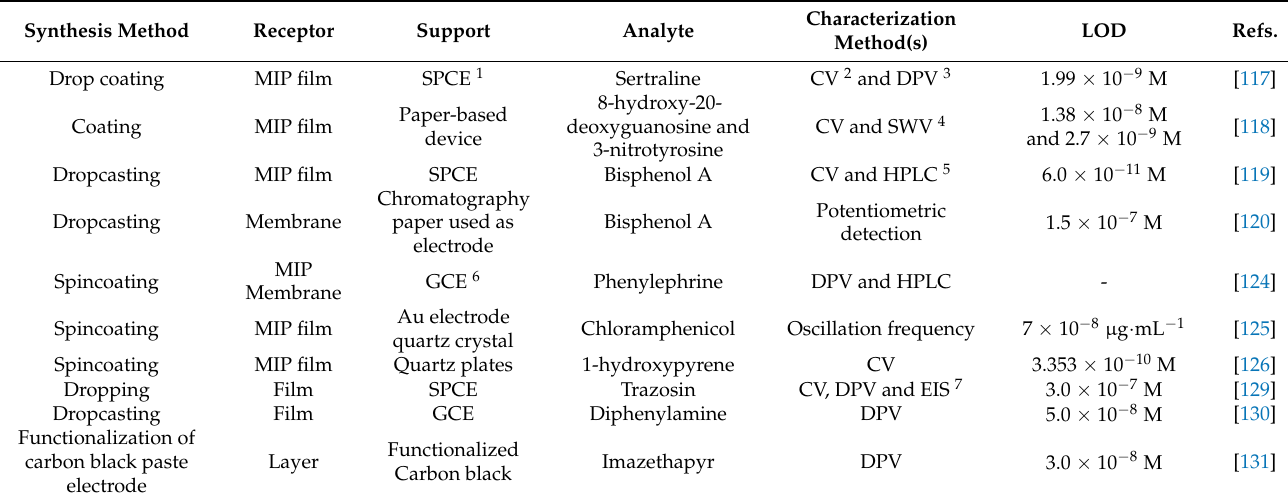
Table 3. MIP-based sensors obtained using MIP particles embedded in pastes or